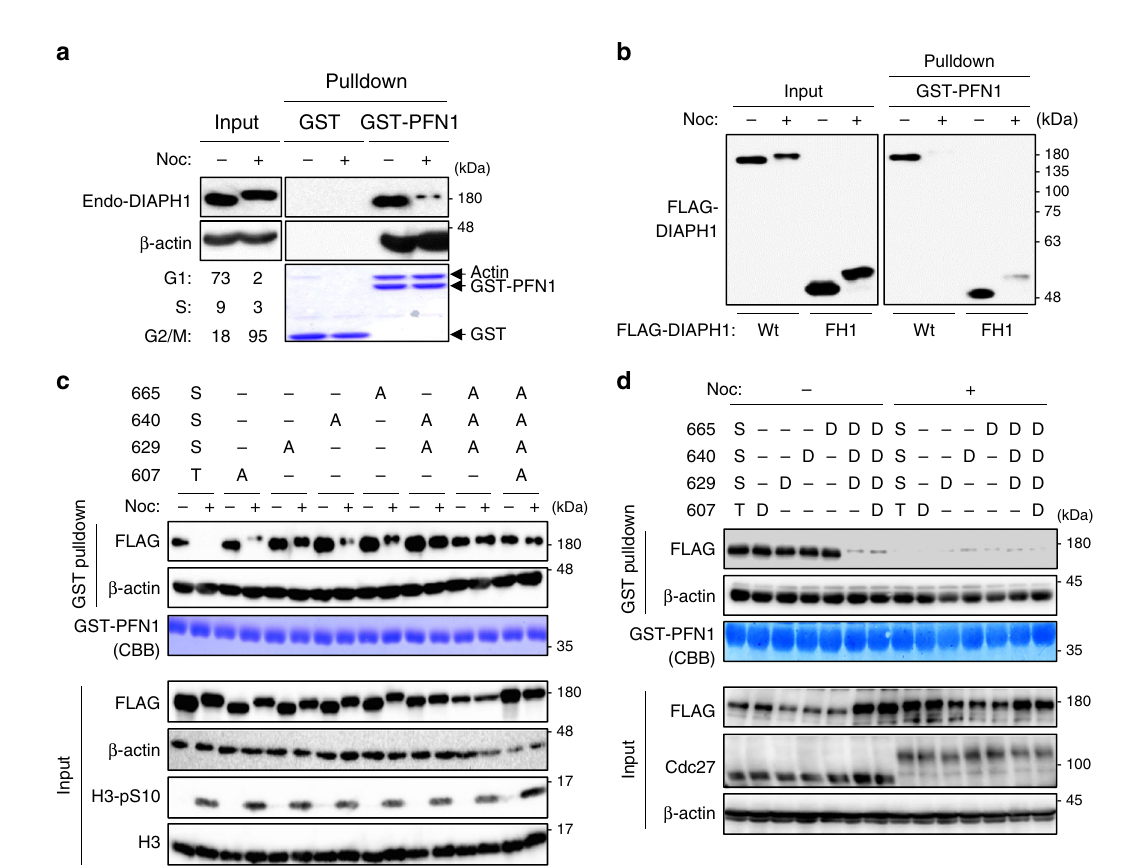
Fig. 2 The FH1 phosphorylation suppresses DIAPH1 – PFN1 interaction. a HeLa cells were treated with nocodazole for 18 h, and collected by mitotic shake- off. Cell lysates were incubated with GST-PFN1 and then subjected to a GST pull-down assay. The resultant precipitates were subjected to immunoblotting using the indicated antibodies. The DNA content of each sample was determined by FACS. b HeLa cells expressing 3×Flag-DIAPH1-Wt or its FH1 domain were treated and collected as in a . The lysates were incubated with GST-PFN1 and then subjected to a GST pull-down assay. The resultant precipitates were immunoblotted using anti-FLAG antibodies. c , d HeLa cells expressing 3×FLAG-DIAPH1-Wt or the indicated mutants were treated and collected as in a . Cell lysates were subjected to GST-pull-down experiments using GST-PFN1 and immunoblotting using the indicated antibodies. Transferred PVDF membranes were stained with Coomassie Brilliant Blue G-250